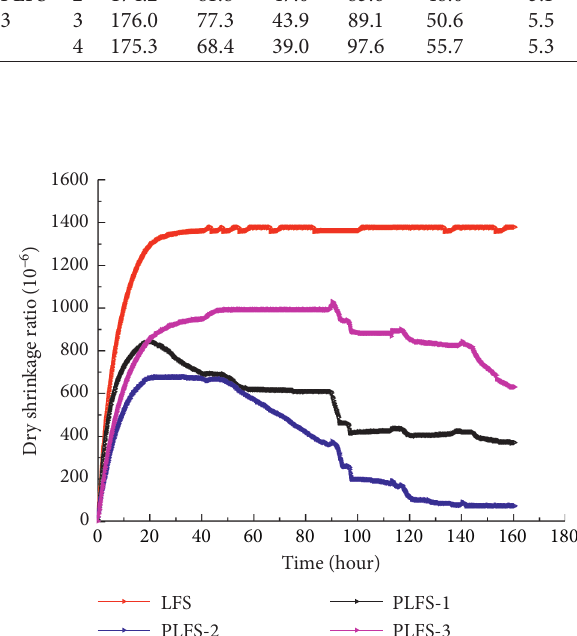
Figure 8: Dry shrinkage ratios of various solidified